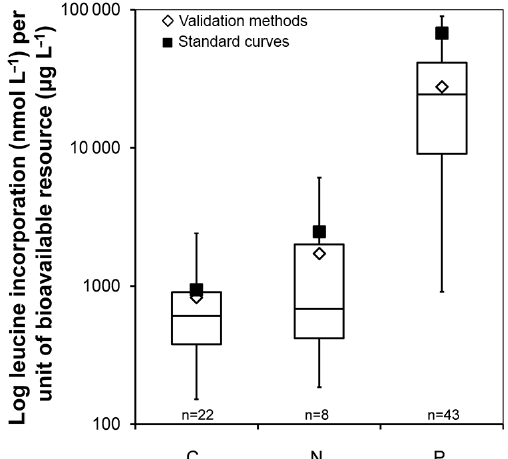
Figure 5. Log-scale box plots of incubation show leucine amounts per unit of bioavailable nutrient measured with validation methods: bacterial respiration (C), cytometry (N), and harvesting of cells in filters (P). Diamonds are average values for the validation methods and filled squares are average slope values for standard curves (same values as slopes in Fig. 2). Table 3. Resource bioavailability in relation to the total resource pool, shown as percent bioavailable dissolved organic carbon (BDOC), bioavailable dissolved nitrogen (BDN) and bioavailable dissolved phosphorus (BDP). The data are divided into two groups which show average results for rivers with more than 10mgCL − 1 (rivers > ; n = 3) and rivers with less than 10mgCL − 1 10mgCL − 1 (rivers < ; n = 4). Average element ratios of carbon to ni- 10mgCL − 1 trogen (C:N), carbon to phosphorus (C:P), nitrogen to phospho- rus (N:P) are calculated in molar for total (tot) and bioavailable resource fractions (bio). Ratios of dissolved inorganic nitrogen to phosphate (DIN:PO 4 -P) are also provided. Standard deviations are given within parentheses. Variable